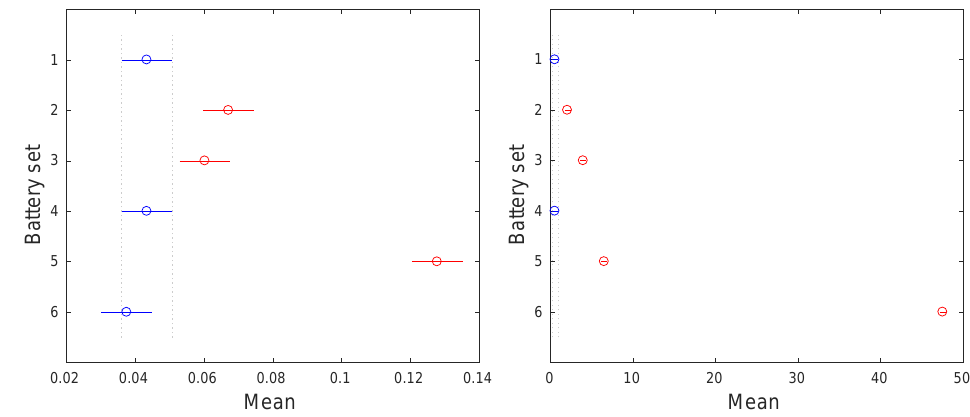
Figure 9. The post-hoc analysis of means of temperature ( left ) and voltage ( right ) ranges during discharging